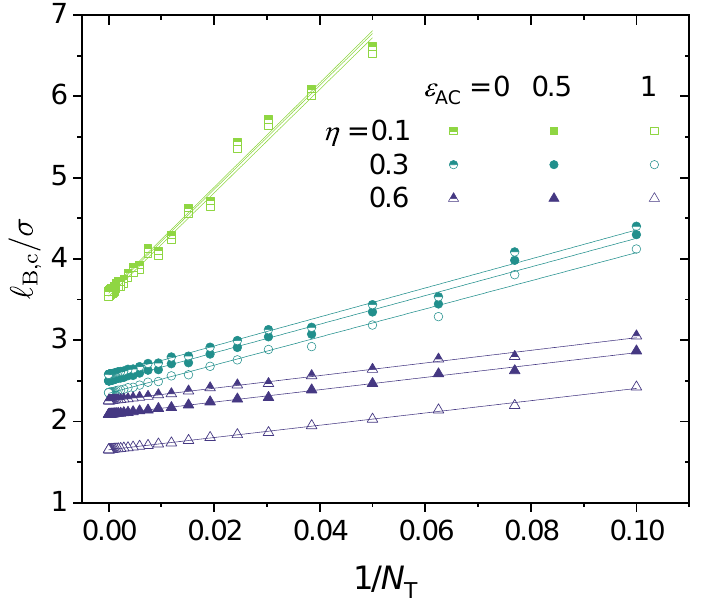
Figure 9. The scaling relationship: (cid:96) B,c ∼ N − 1 (cid:101) A = (cid:101) B = 0, Z A = − 1 and Z C = + 2. Values for N T is were varied, therefore N 1 = 1/3 N T η − 1 was varied as